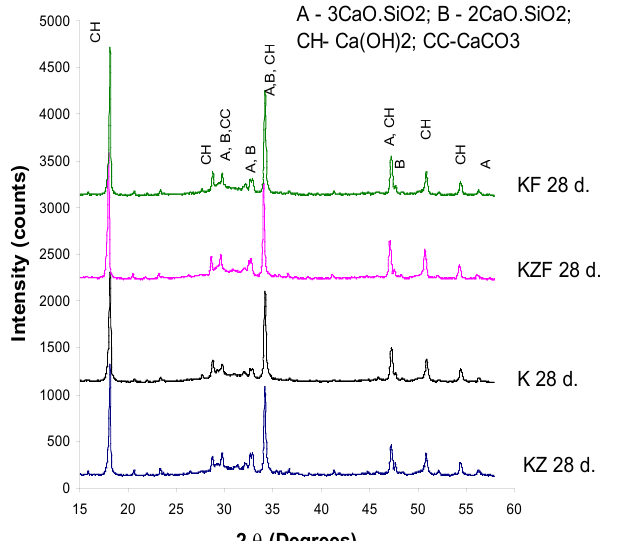
Figure 8. XRD spectra of pastes hydrated 28 days.